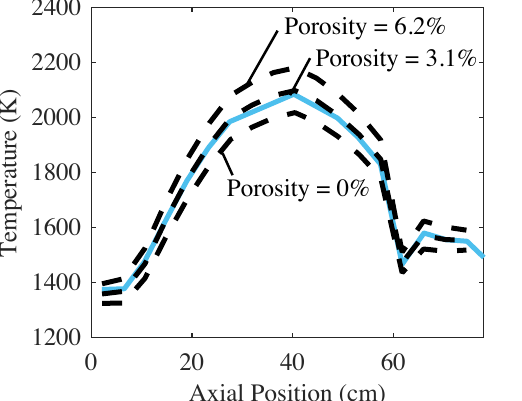
Figure 4. Outlet coolant temperature during an overpower event in MOX and Metal fueled fast reactors with pitches of 0.7662 cm, 0.8662 cm, and 0.9662 cm and constant velocity. Metal fueled reactor results shown by blue line, MOX fueled reactor results by the red dashed line . As expected, decreasing the pitch increases the initial steady-state outlet temperature due to a smaller body of sodium being available to absorb heat generated by the fuel. Additionally, decreasing the pitch from 0.9662 cm to 0.7662 cm increases the temperature increase during the transient from 20.5 K to 56.7 K.